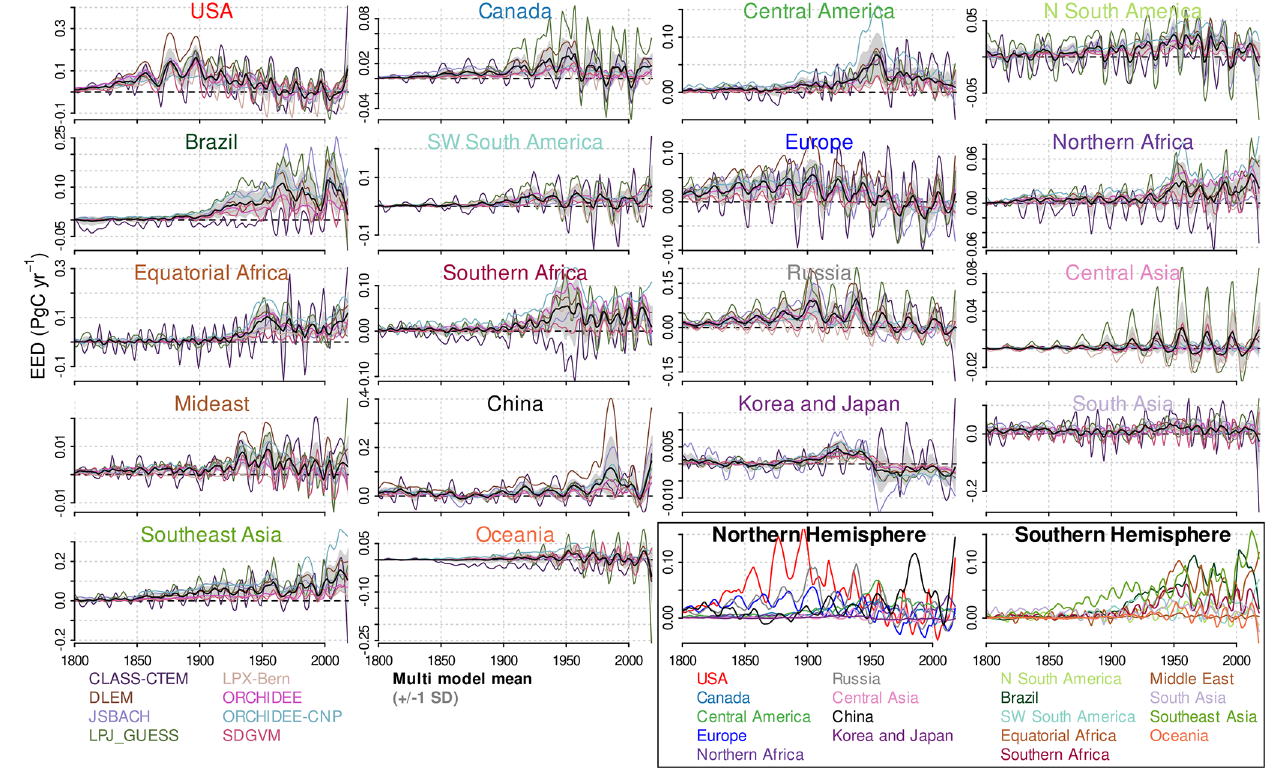
Figure A6. Region-wise smoothed annual difference between the f LULCC under present-day and pre-industrial environmental conditions (environmental equilibrium difference, EED) in the used models from 1800 to 2018, derived according to Eq. 6. For a discussion of individual models refer to Sect. A1. EED was not derived for CLM5.0, JULES, LPJ, and OCN (compare Table 2). The last two panels show regional ensemble means on a uniform